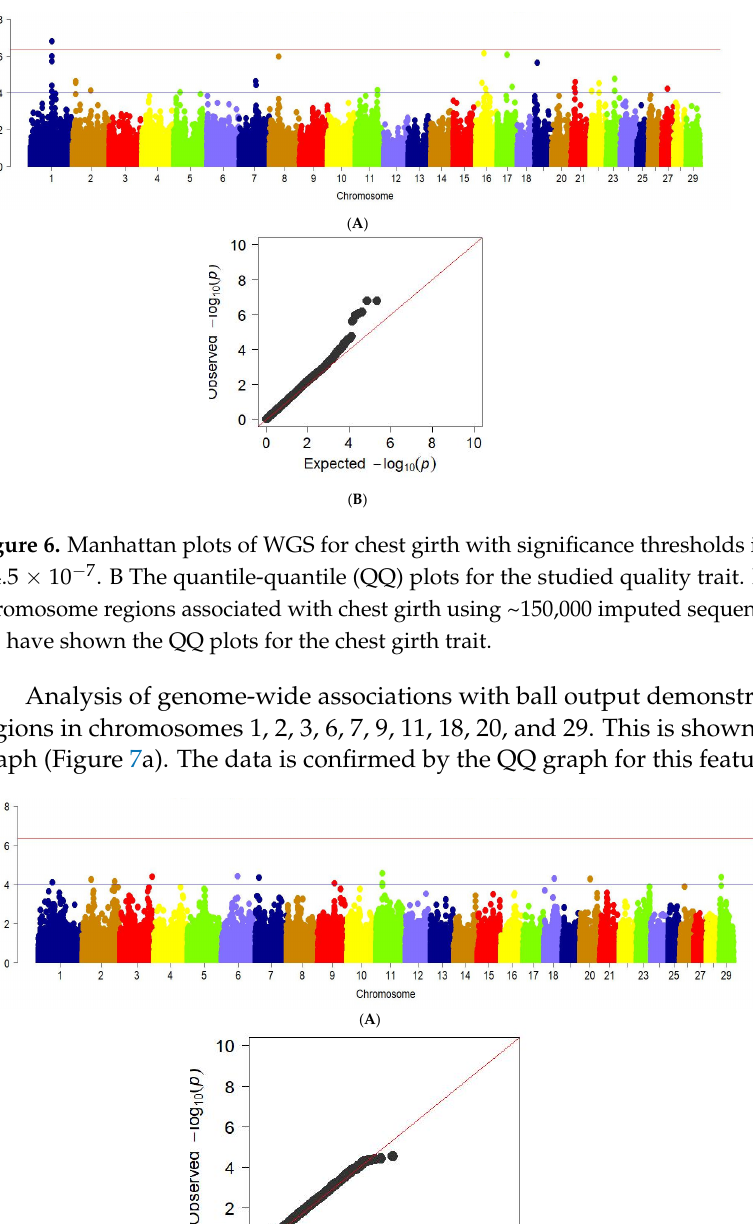
Figure 5. ( a ) Manhattan plots of WGS for chest width with significance thresholds indicated at − log10 p > 4.5 × 10 − 7 ; Panel ( a ) shows the chromosome regions associated with chest width, using ~150,000 imputed sequence SNPs. ( b ) The quantile-quantile (QQ) plots for the studied quality trait. Panels ( b ) have shown the QQ plots for the chest width trait.